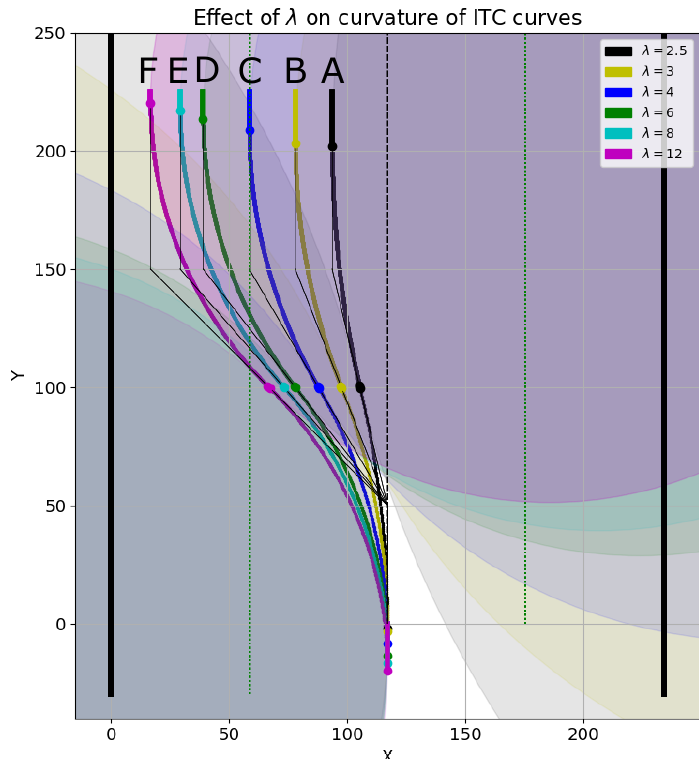
Figure 23. Effect of λ on different ITC curve generations for smooth left turns.